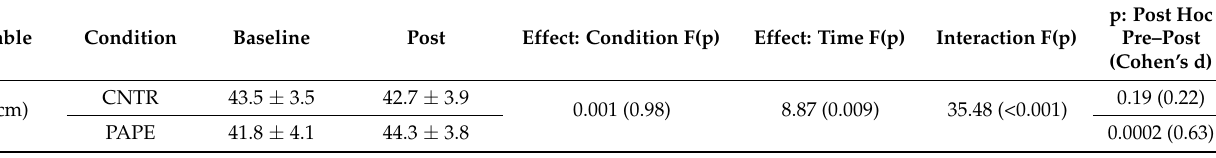
Table 2. Results of jumping tests for positive responders (six participants in CMJ, eight in SJ) at the baseline and after CA (presented as mean ±